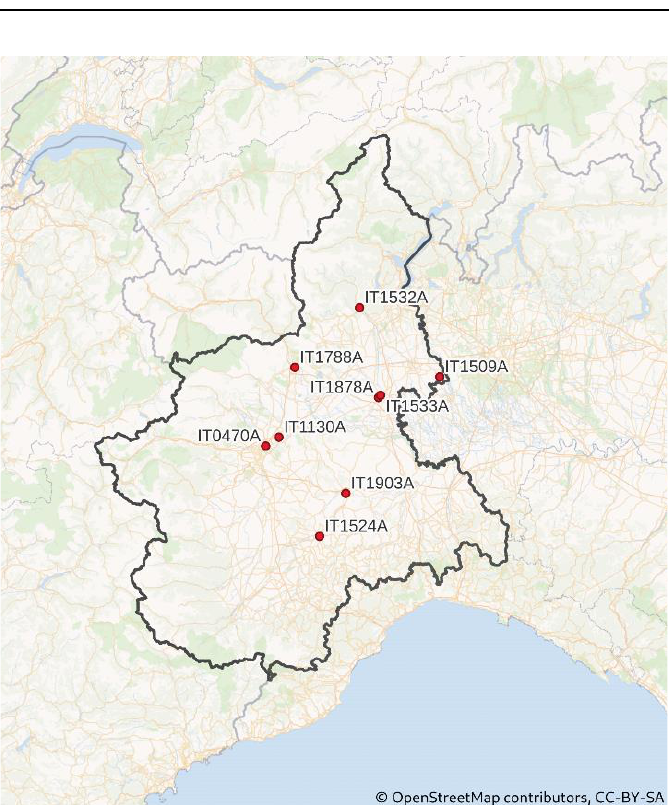
Figure 1. Italy, Piedmont region: selected stations from regional air quality monitoring network.